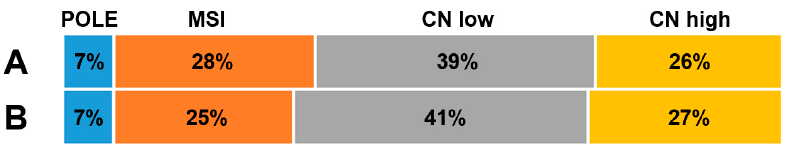
Figure 1. Distribution of EC subtypes POLE, MSI, CN-low, and CN-high in the EC cohort (n = 232) after application of TCGA ( A ) and MH Guide algorithm ( B ).